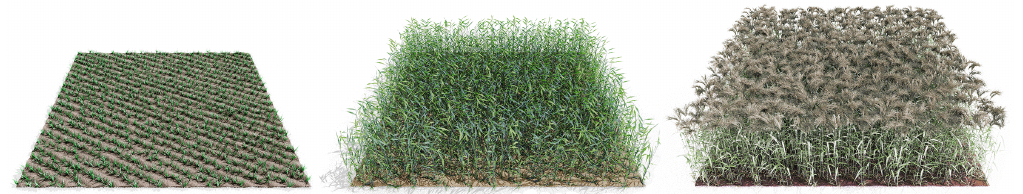
Figure 2. Example canopies for early tillering (left), late stem elongation (middle) and early ripening (right) for rye (left), wheat (middle) and barley (right).The images are sampled with drat and the colours correspond to spectral characteristics.